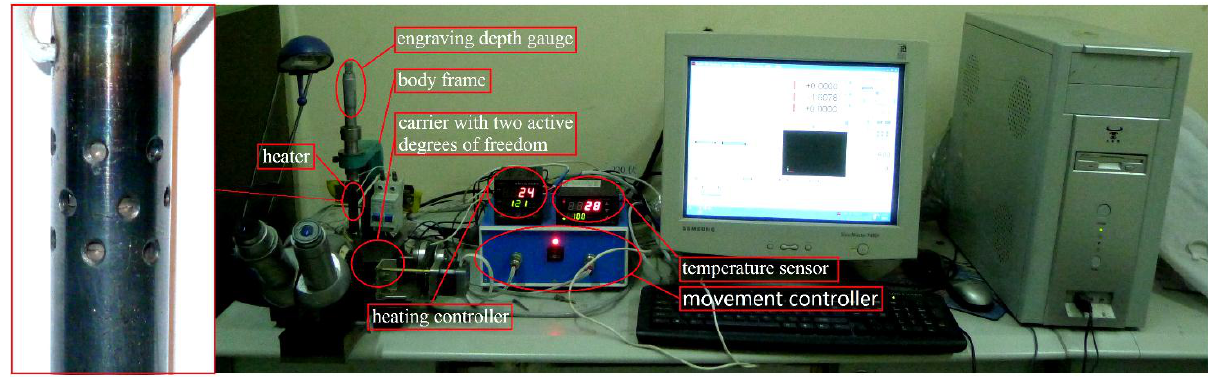
Figure 1. The composition of the